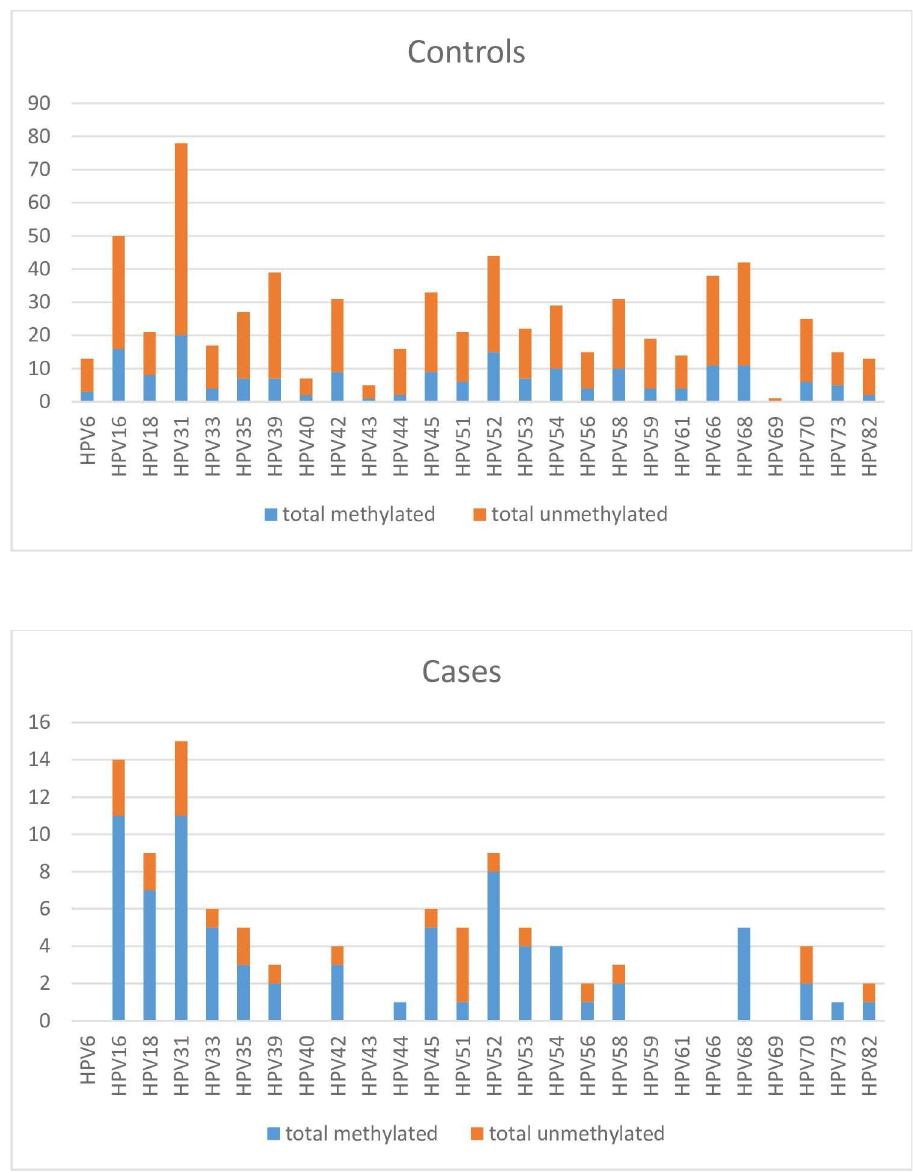
Fig 3. Genotype-specific hypermethylation patterns in samples among controls (normal cytology, � LSIL cytology, LSIL histology, and normal histology) and cases ( � HSIL histology).